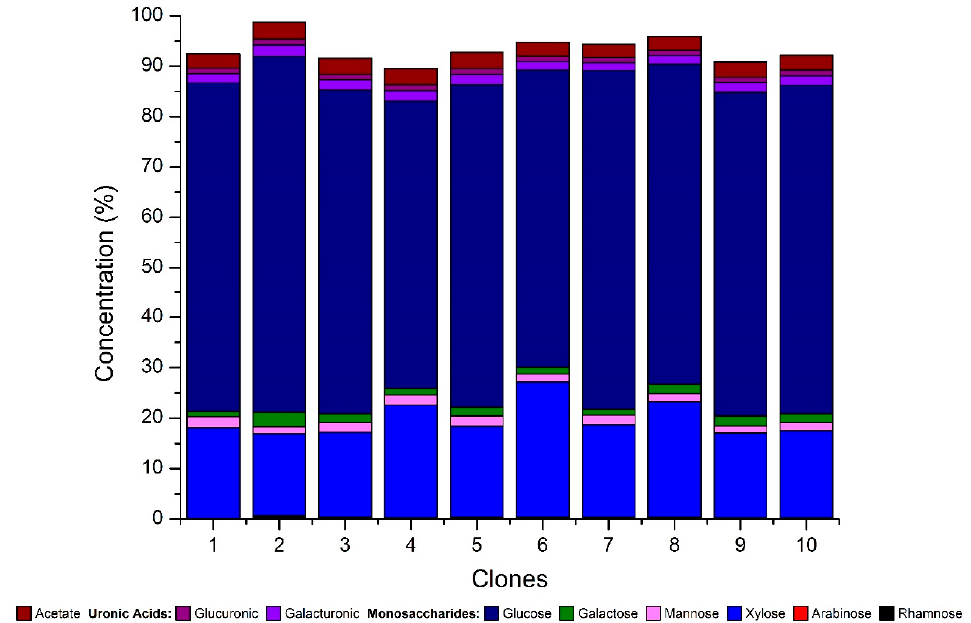
Figure 3. Chemical composition of monosaccharides, uronic acids and acetate of Eucalyptus spp . clones.